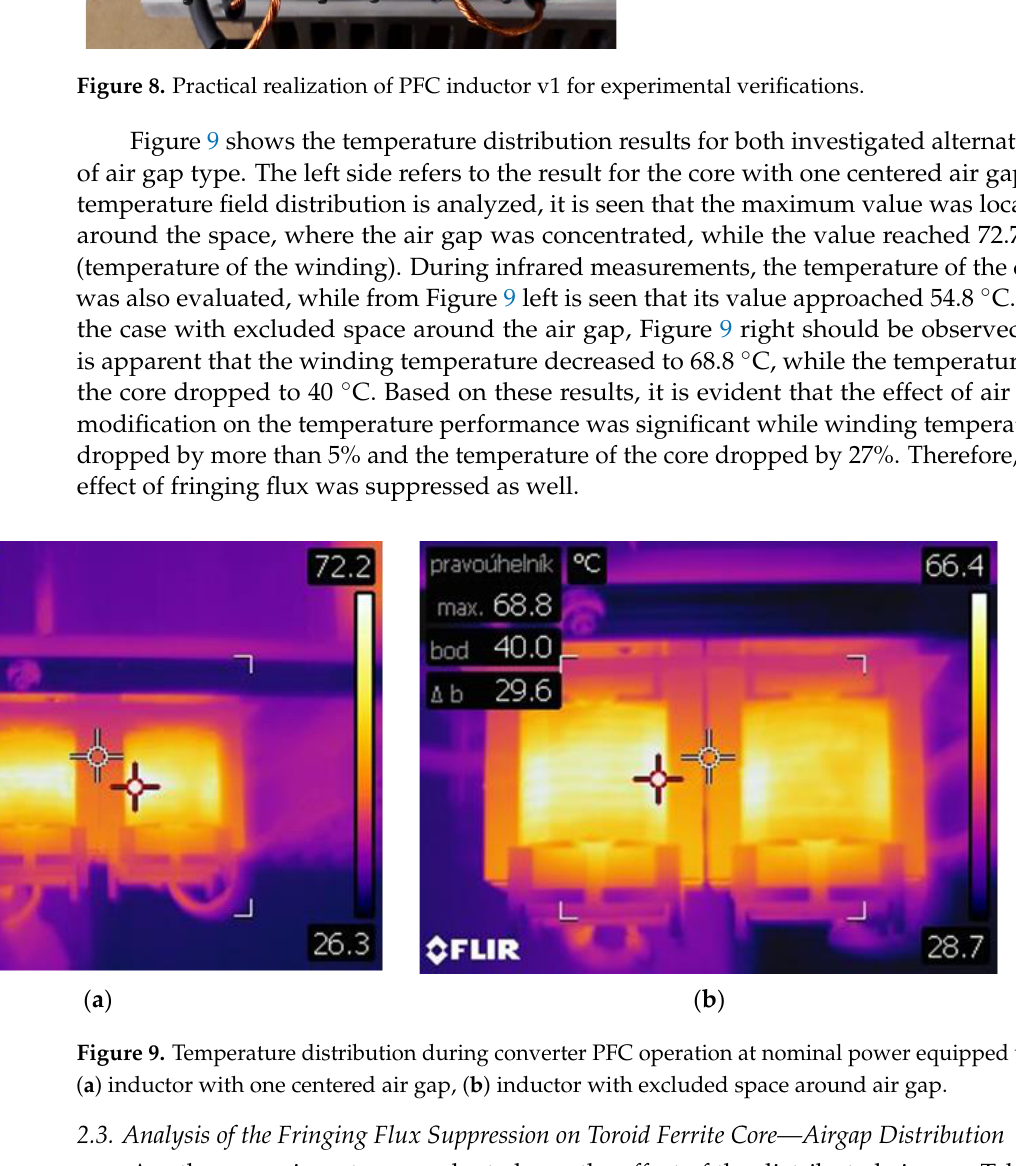
Table 2. Parameters of PFC inductor v2 for analysis of distributed airgap influence.